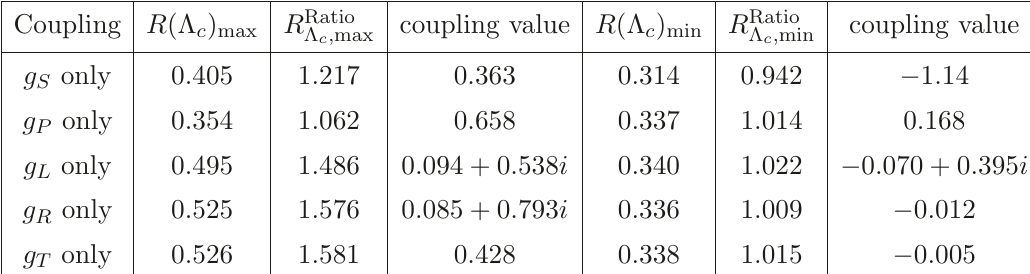
Table 4 . The maximum and minimum values of R (Λ c ) and R Ratio straints for each new-physics coupling, and the coupling values at which these extrema are